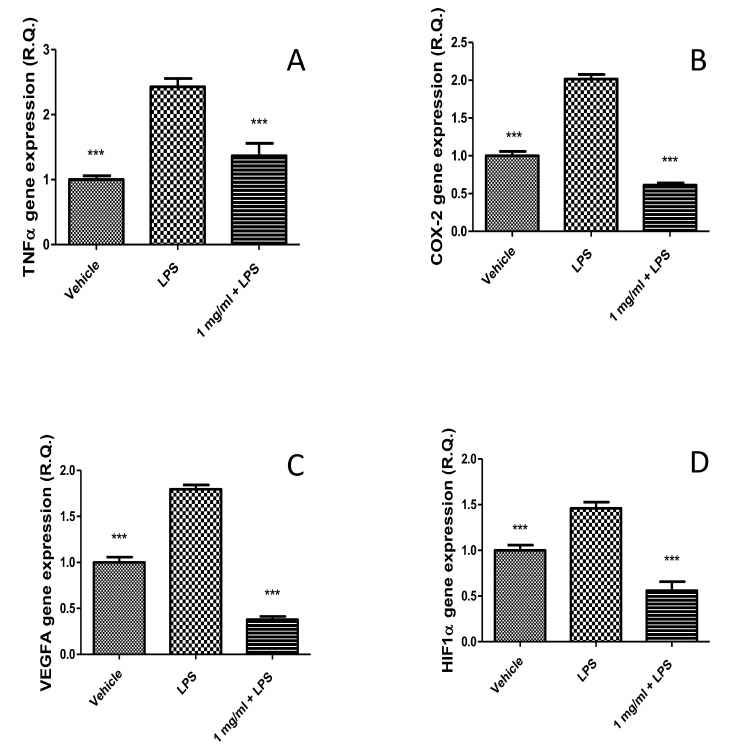
Figure 6. Inhibitory effects induced by Prunus mahaleb L. water extract (1 mg/mL) on LPS-induced upregulation of TNF α ( A ), COX-2 ( B ), VEGFA ( C ), and HIF1 α ( D ) gene expression in isolated mouse colon. ANOVA, p < 0.0001; *** p < 0.001 vs. respective LPS